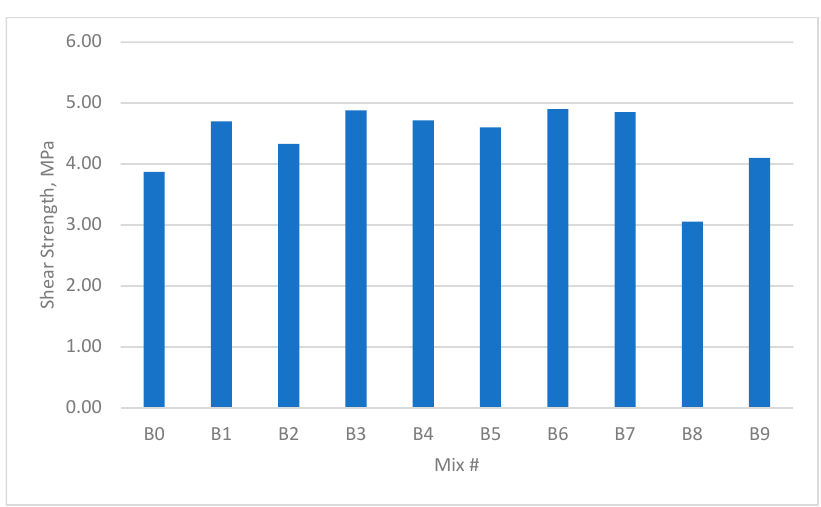
Figure 7. Shear strength of concrete beams with W/B ratio 0.35.